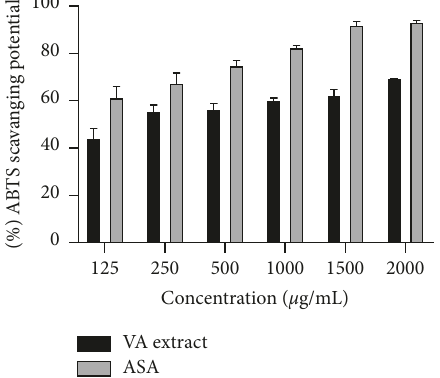
Figure 2: % ABTS radicals scavenging potential of V. album extract and Ascorbic acid.